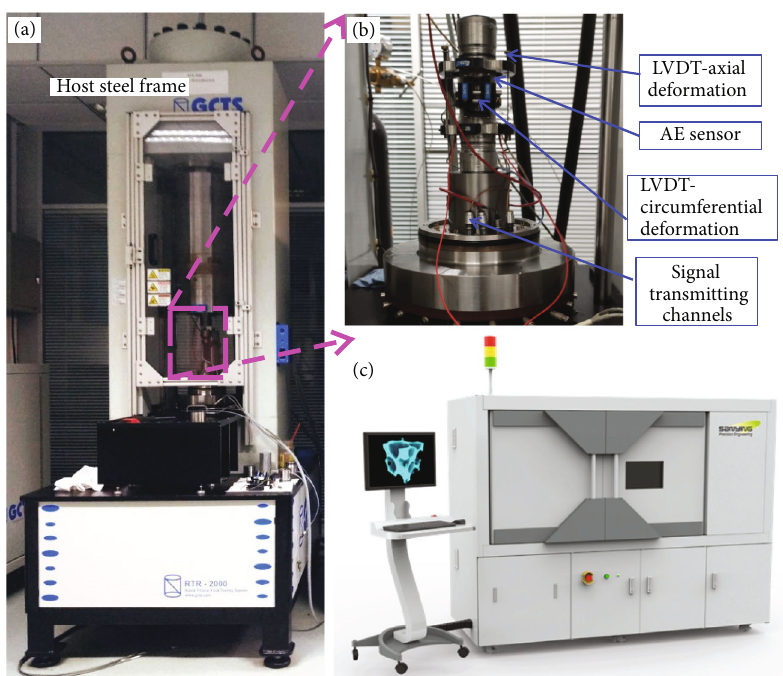
Figure 6: The experimental devices used in this work. (a) The rock mechanics machine. (b) The LVDT systems used to measure the axial and lateral deformation. (c) The 450kV industrial CT system used to obtain the crack pattern of